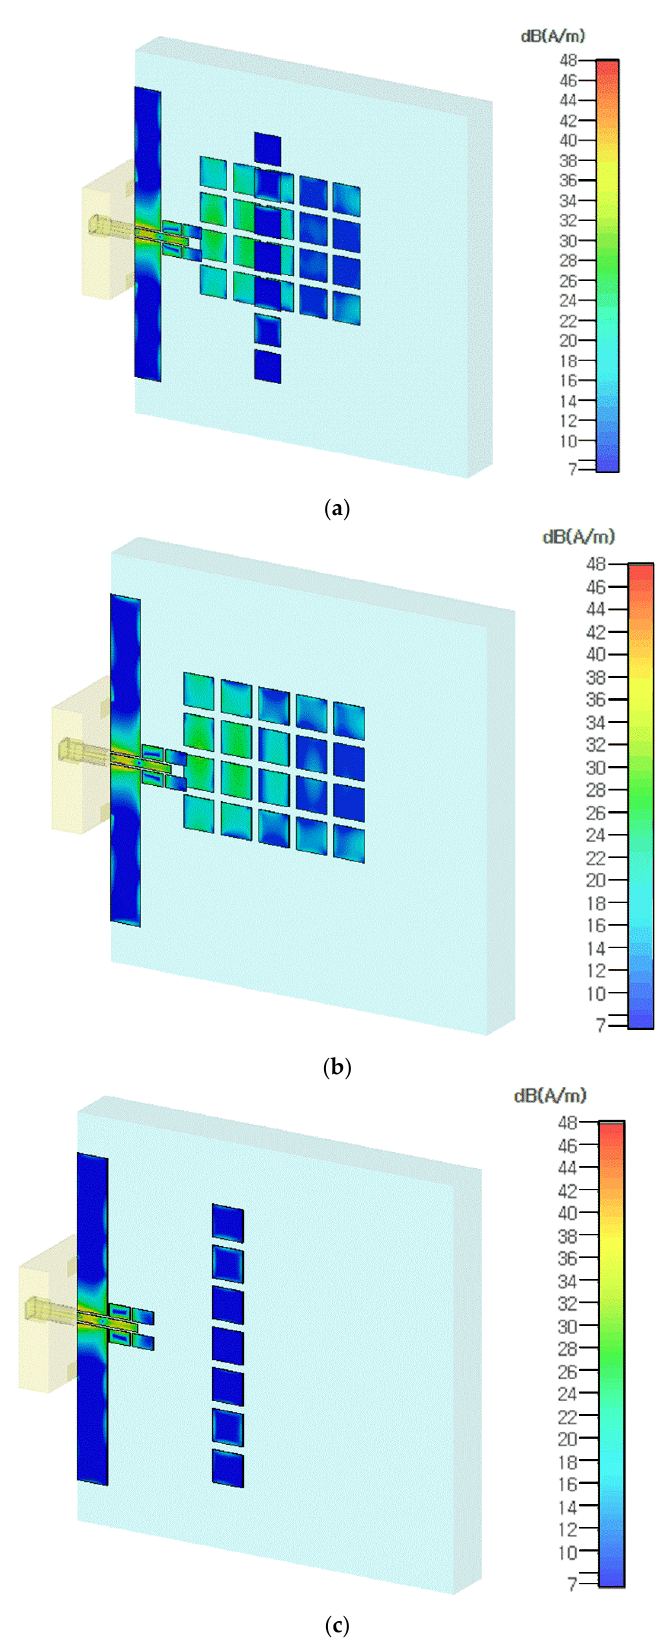
Figure 14. Current distributions: ( a ) proposed antenna; ( b ) without the director; ( c ) without the